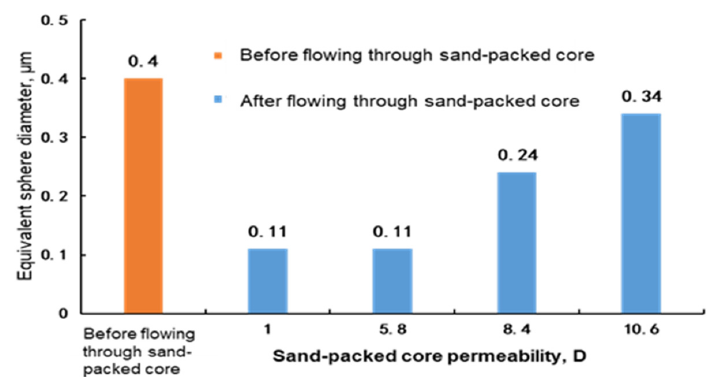
Figure 2. Measurement of equivalent sphere diameter of polymer before and after flowing through sand-packed cores.